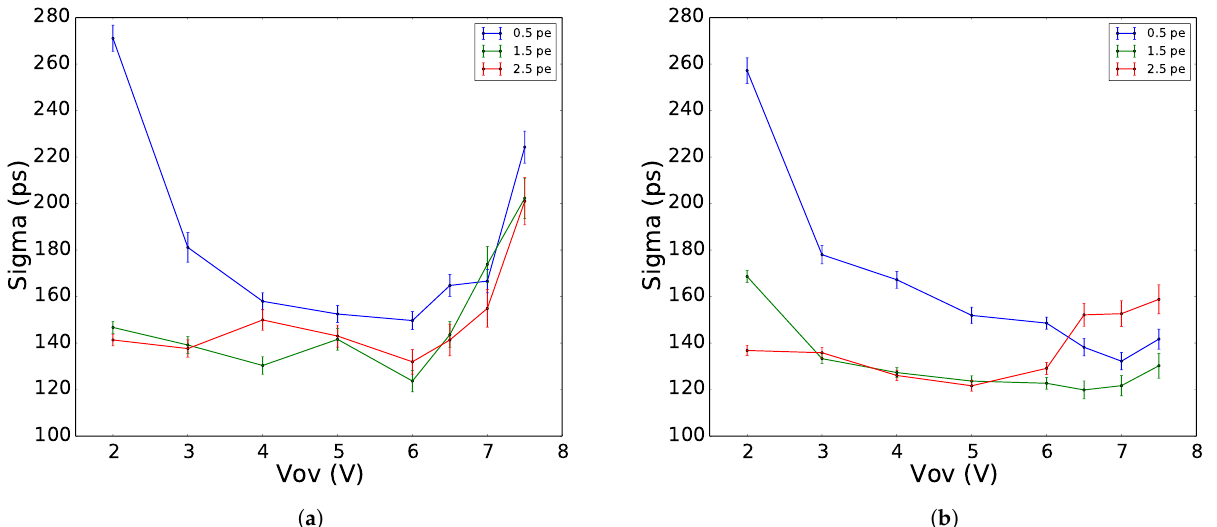
Figure 13. SPTR as a function of the over-voltage and different threshold levels using the Hamamatsu SiPM S13360 − 3075CS. ( a ) SPTR without PZ cancellation; ( b ) SPTR with PZ